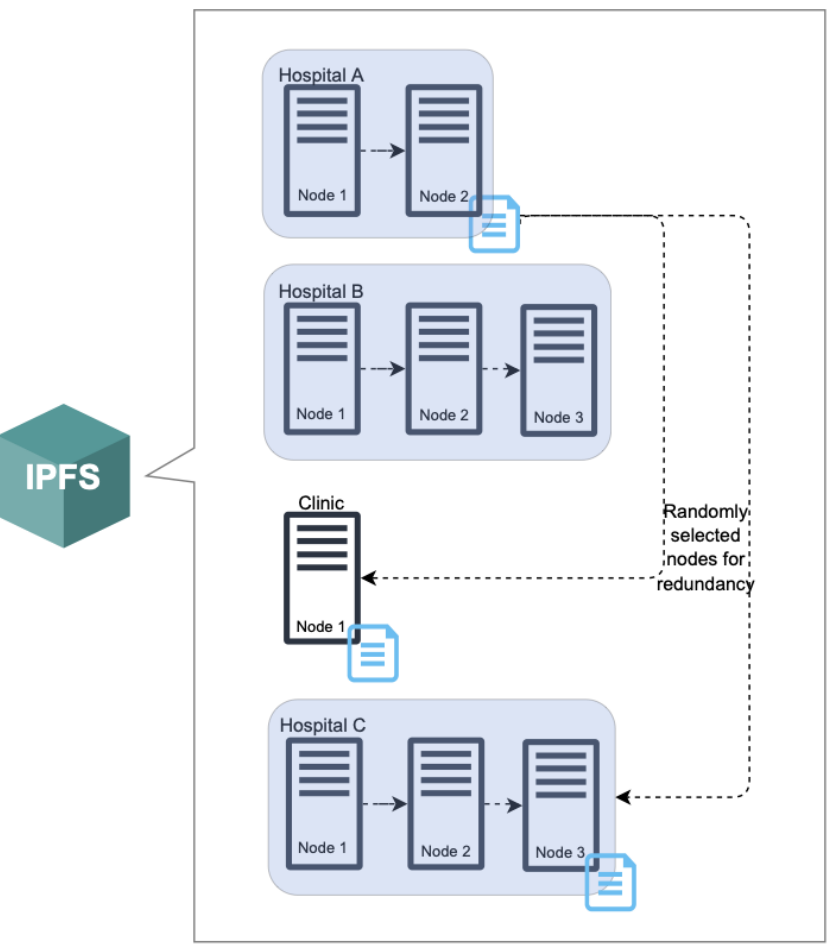
Figure 20. IPFS redundancy for EHRChain.